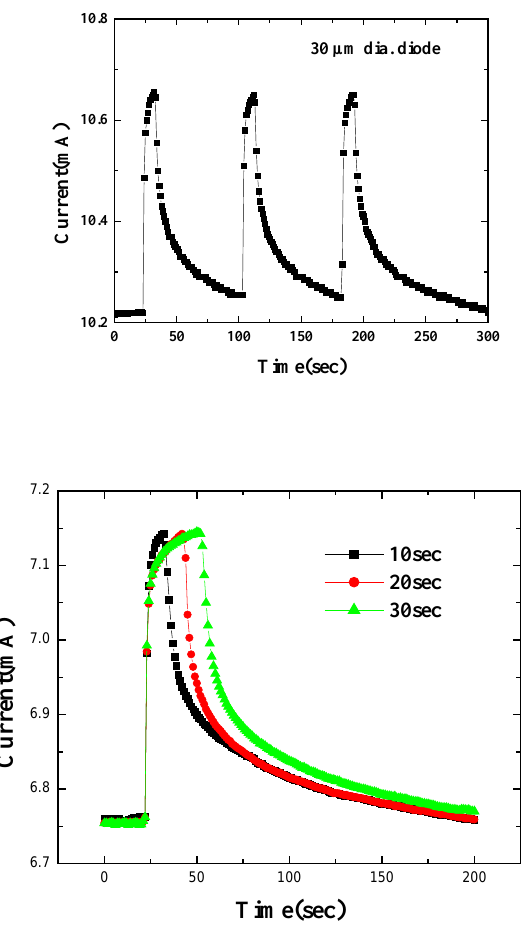
Figure 4. Time response at 25°C of MOS-HEMT based diode forward current at a fixed bias of 2V when switching the ambient from N to pure N (bottom) and three cycles of switching the ambient from N 2 10 (top)